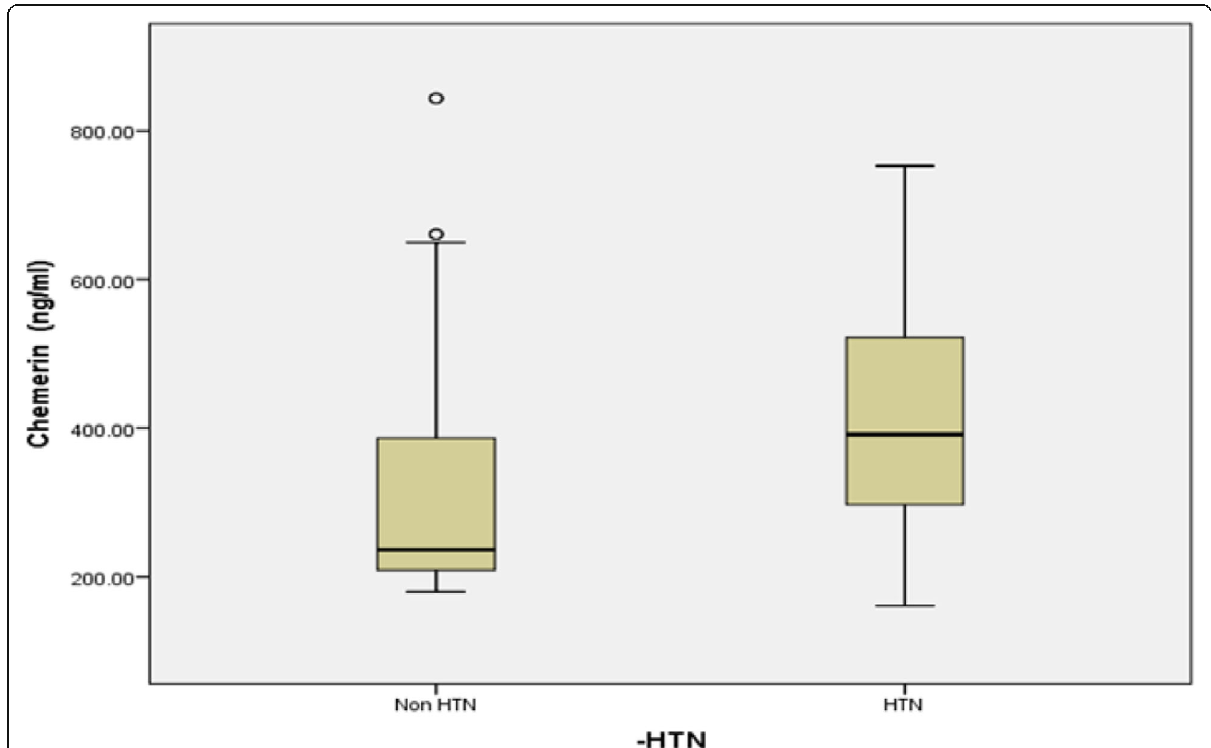
Fig. 2 Box plot between hypertensive (HTN) and non-hypertensive (non-HTN) according to serum chemerin levels